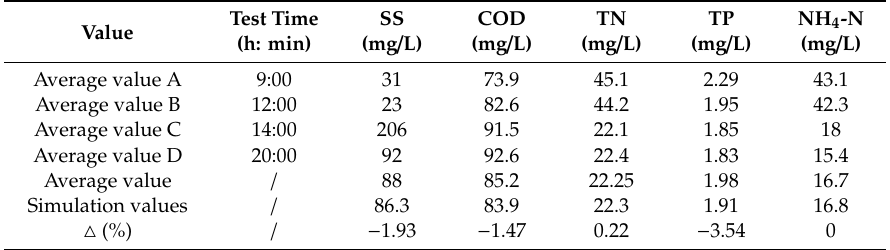
Table 2. Fitting table of sewage quality in dry